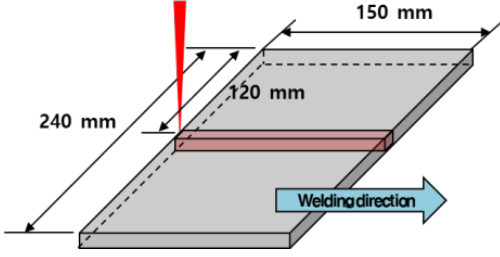
Table 1. Chemical composition of the base metal (wt%).